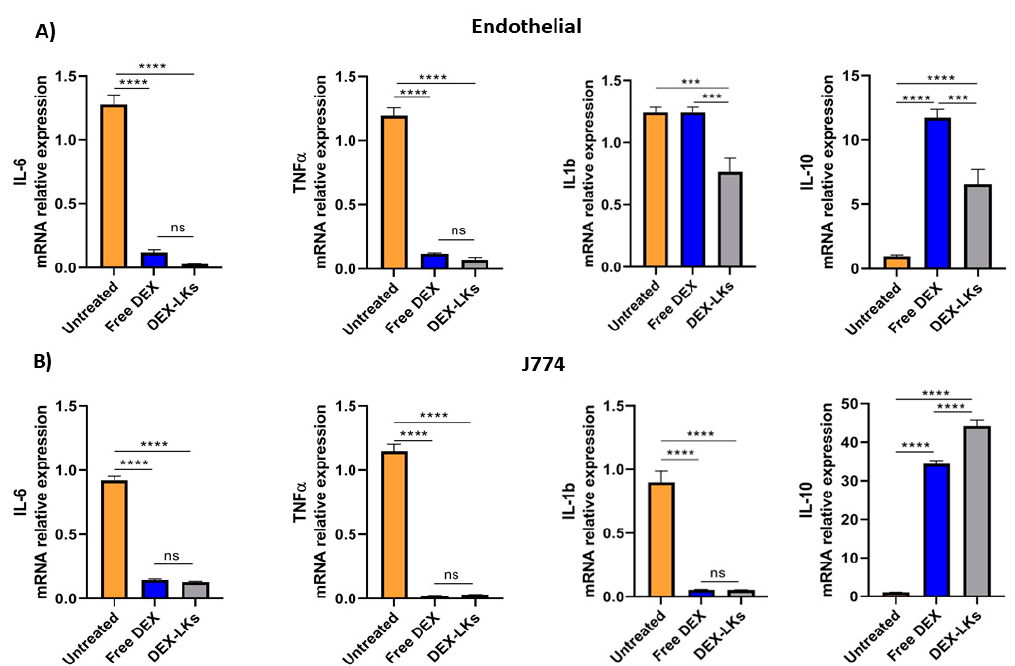
Figure 2. In vitro experiments. mRNA expression levels of pro and anti-inflammatory cytokines evaluated in murine endothelial ( A ) and macrophage ( B ) cells inflamed with LPS and then treated with free Dexamethasone (Free DEX), Dexamethasone-loaded leukosomes (DEX-LKs) or left untreated (Untreated). Data are expressed as mean ± SEM from three independent experiments. Asterisks depict significant differences (**** < 0.0001 and *** 0.0002). ns: not significant.